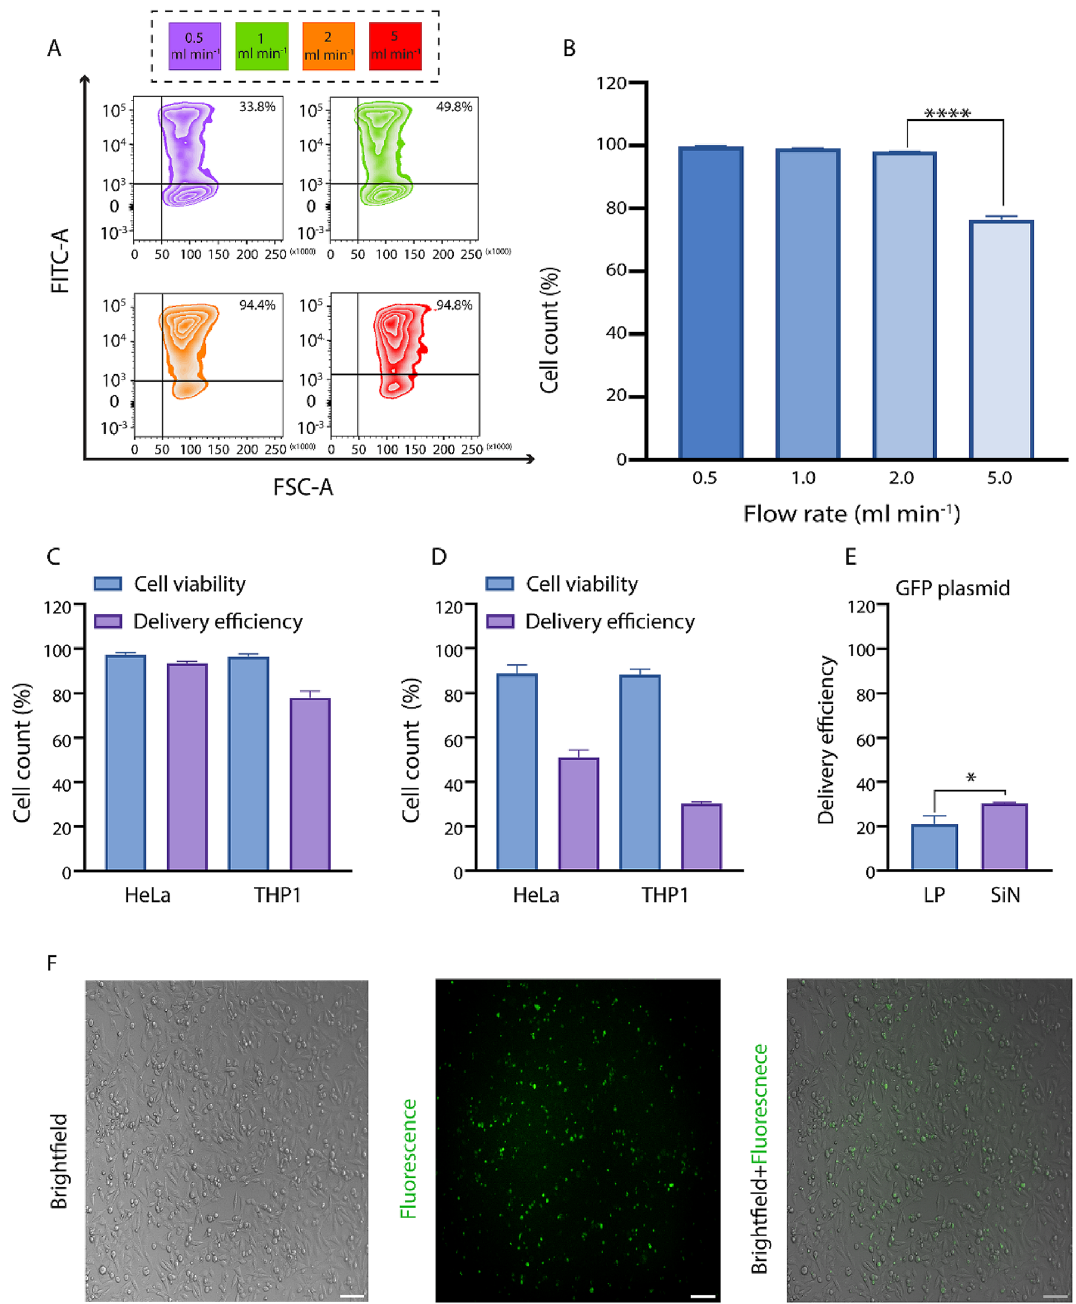
Figure 3. Delivery performance of the MFP setup with SiN microsieves. ( A ) The optimal flow rate was defined at 2 ml min −1 , in which the cells demonstrated the highest rate of cell viability (~ 98%) and delivery efficiency (94.4%). ( B ) The viability of cells that traversed the SiN micropores showed a sharp decrease at the flow rate of 5 ml min −1 . ****Indicate the P -value < 0.0001. ( C , D ) These bar plots display successful delivery of 70 kDa ( C ) and 2000 kDa ( D ) FITC-dextran molecules into both adherent (HeLa) and suspension (THP1) cell lines. ( E ) This bar plot demonstrates the successful loading of plasmid DNA encoding GFP-tagged histone H2B into the HeLa cells. LP: Lipofection, SiN: MFP setup with SiN membranes. *Indicate the P -value < 0.05. ( F ) Brightfield, fluorescent, and merged images of HeLa cells 18 h after processing via MFP using SiN microsieves. Scale bar represents 100 µm. All error bars represent the mean ± standard error of the mean, N =